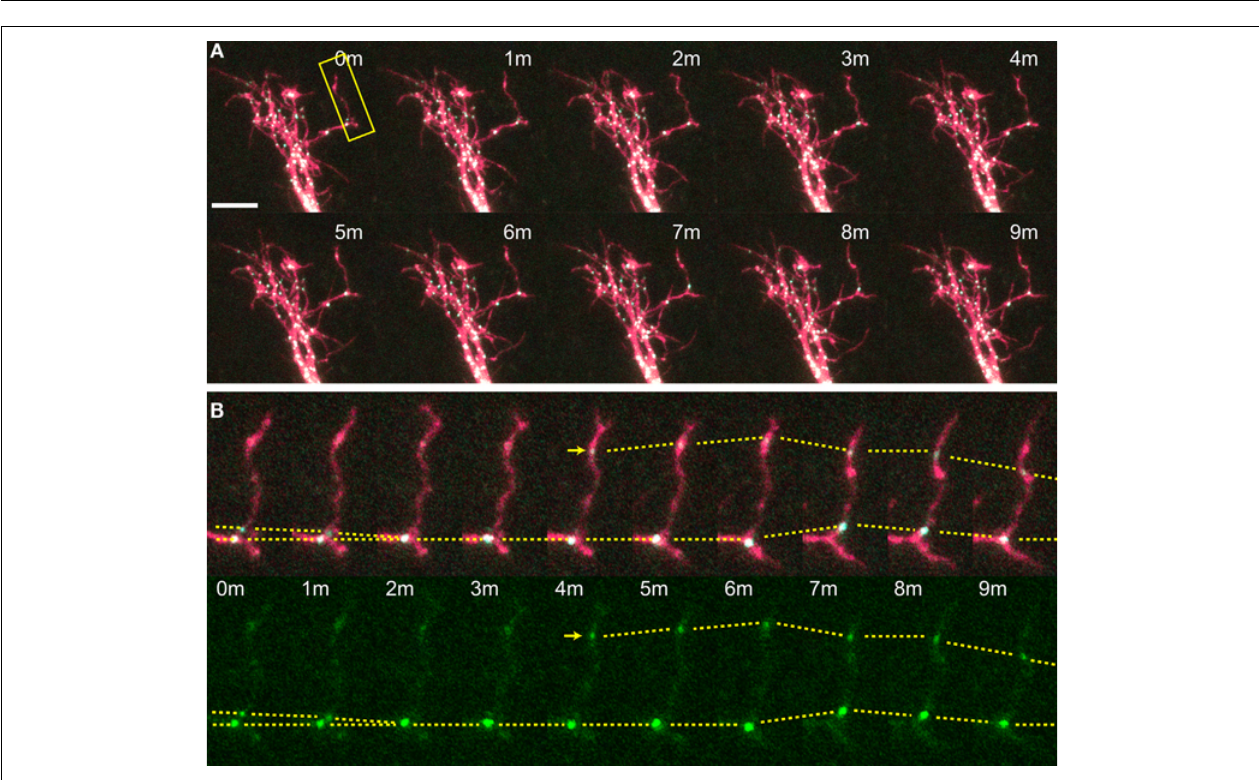
of locations of one punctum over the 12 min, with the current position in yellow, past positions in white. Smaller insert illustrates the rapid fusing and splitting of puncta. Scale bar = 10 µm. See also Supplementary Video 1.